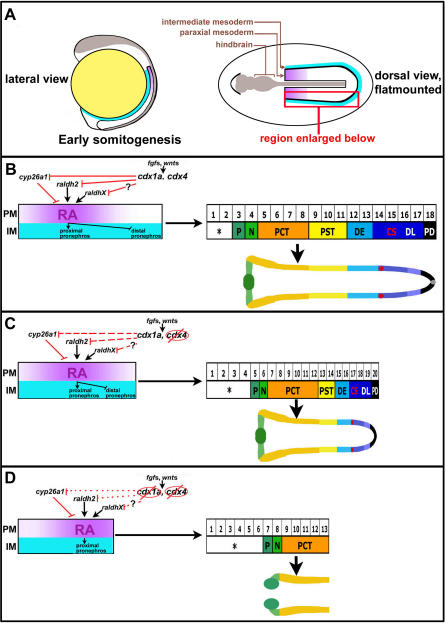
Model for How the cdx Genes and RA Establish Pronephros Position and Segmentation(A) At the end of gastrulation, the IM is located lateral to the PM. The production of RA in the PM is localized to the anterior-most region (purple). RA is proposed to diffuse as a gradient across to the adjacent IM such that the anterior IM is exposed to high RA levels, which induce proximal fates and suppress expansion of distal fates.(B) In wild-type embryos, cdx1a and cdx4 set the expression boundaries of raldh2 (and potentially other putative raldh-like genes, 'raldhX') and cyp26a1, thereby restricting RA production to the anterior PM. The absence of cdx4 function (C) and cdx1a/4 function (D) causes posterior shifts in the RA source, due to the combined posterior shifts of both the raldh2 and cyp26a1 expression domains. These shifts in the presumptive RA zone lead to pronephros formation at a more posterior location, and an expansion of anterior intermediate mesodermal fates (indicated by an asterisk). In cdx1a/4-deficient embryos, the posterior shift of the pronephros, together with the body truncation, results in an abrogation of distal nephron segments.